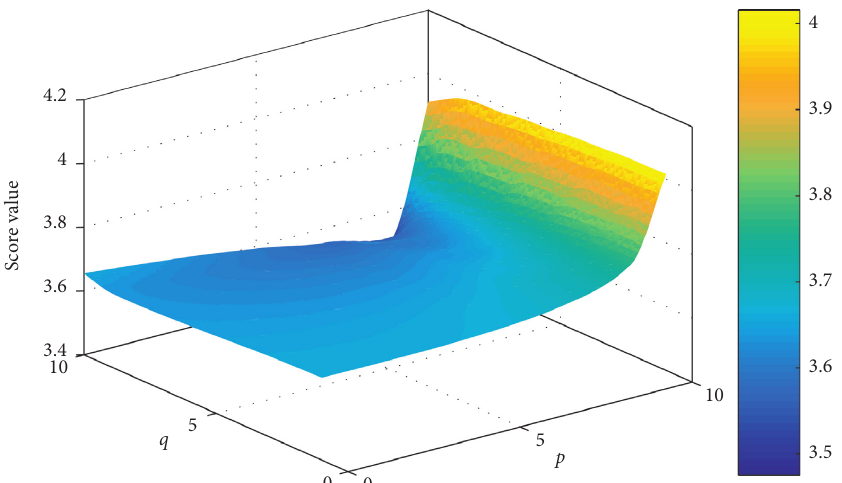
Figure 3: Scores of A